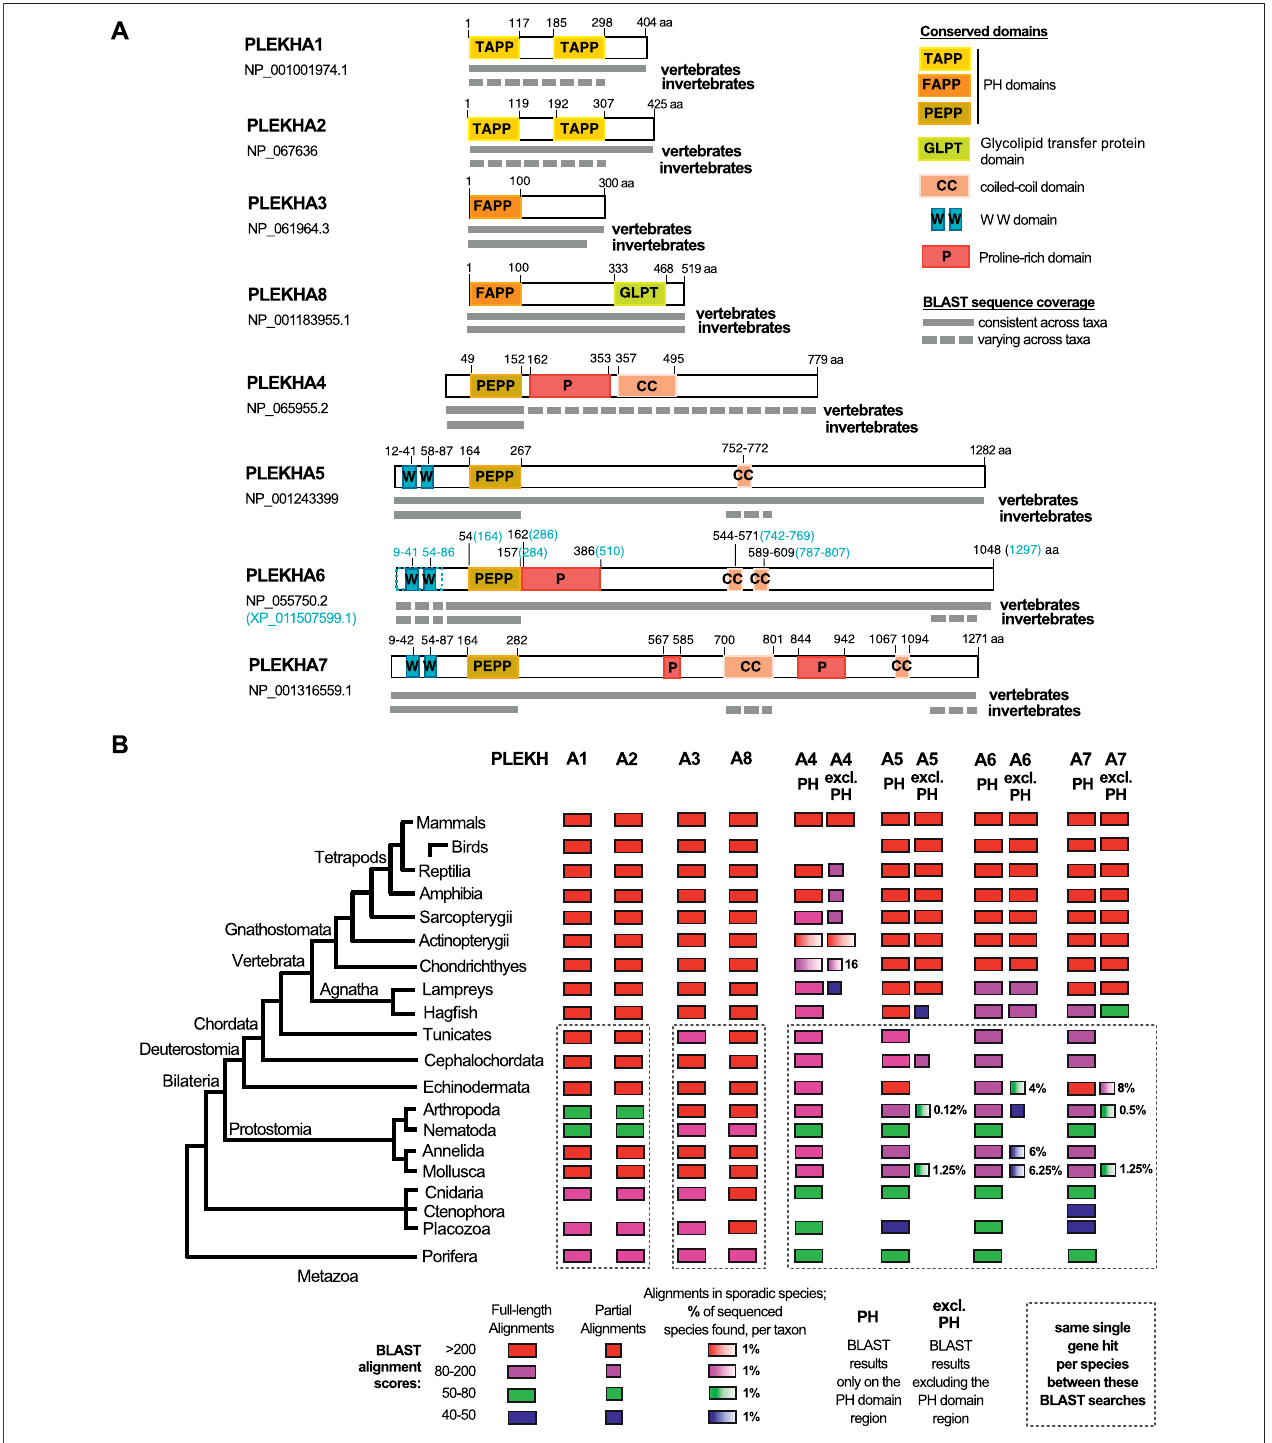
FIGURE 1 | Comprehensive summary of the BLAST searches conducted in the present study. (A) Graphical summaries of the sequence coverage of the human PLEKHA1-8proteinsequencesinmetazoangenomes,asretrievedthroughtheBLASTsearches.Greyboxesdepictsequencecoverageofalignmentsinvertebrateand invertebrate proteins, juxtaposed to their amino acid (aa) position. Colored boxes show the domain organization of the human proteins. See also key panel on the top right. Accession numbers under each PLEKHA name indicate the sequences used for the BLAST searches; a predicted isoform of PLEKHA6 (XP_011507599.1) that includes the documented WW domains of this protein is also outlined, since the single NCBI-veri fi ed PLEKHA6 isoform (NP_055750.2) lacks these domains. (B) Diagram showing sequence identities of the human PLEKHA1-8 proteins in metazoan genomes, as retrieved through the BLAST searches. BLAST results are shown